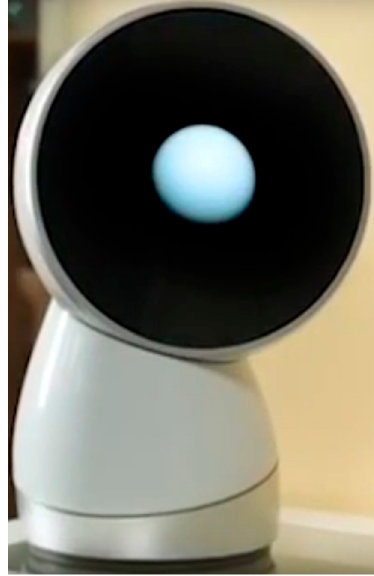
Figure 5. Jibo by Jibo Inc. Image by funny cats. CC BY 4.0; https://www.youtube.com/watch?v=IjsegZciOuI. Cropped and resized to fit.